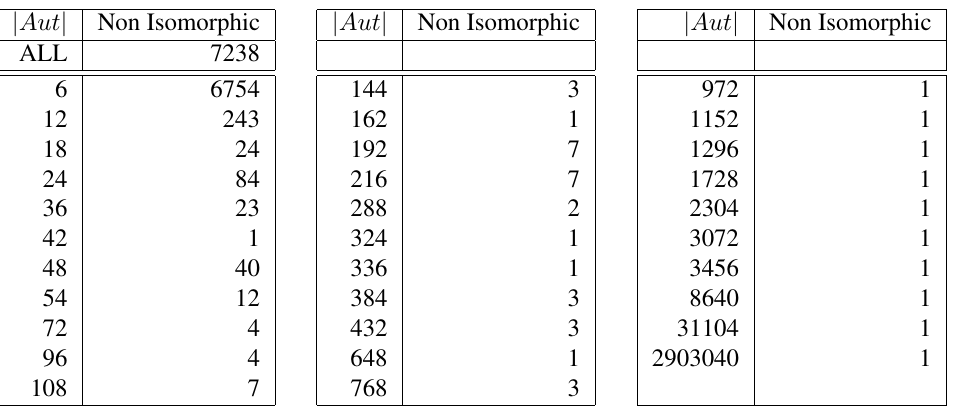
Tab. 1: 7238 Hadamard matrices of order